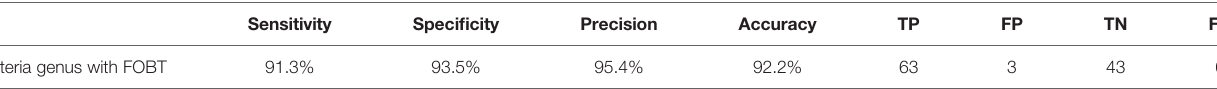
TABLE 2 | The performance of 13 biomarkers including bacteria genus and FOBT.